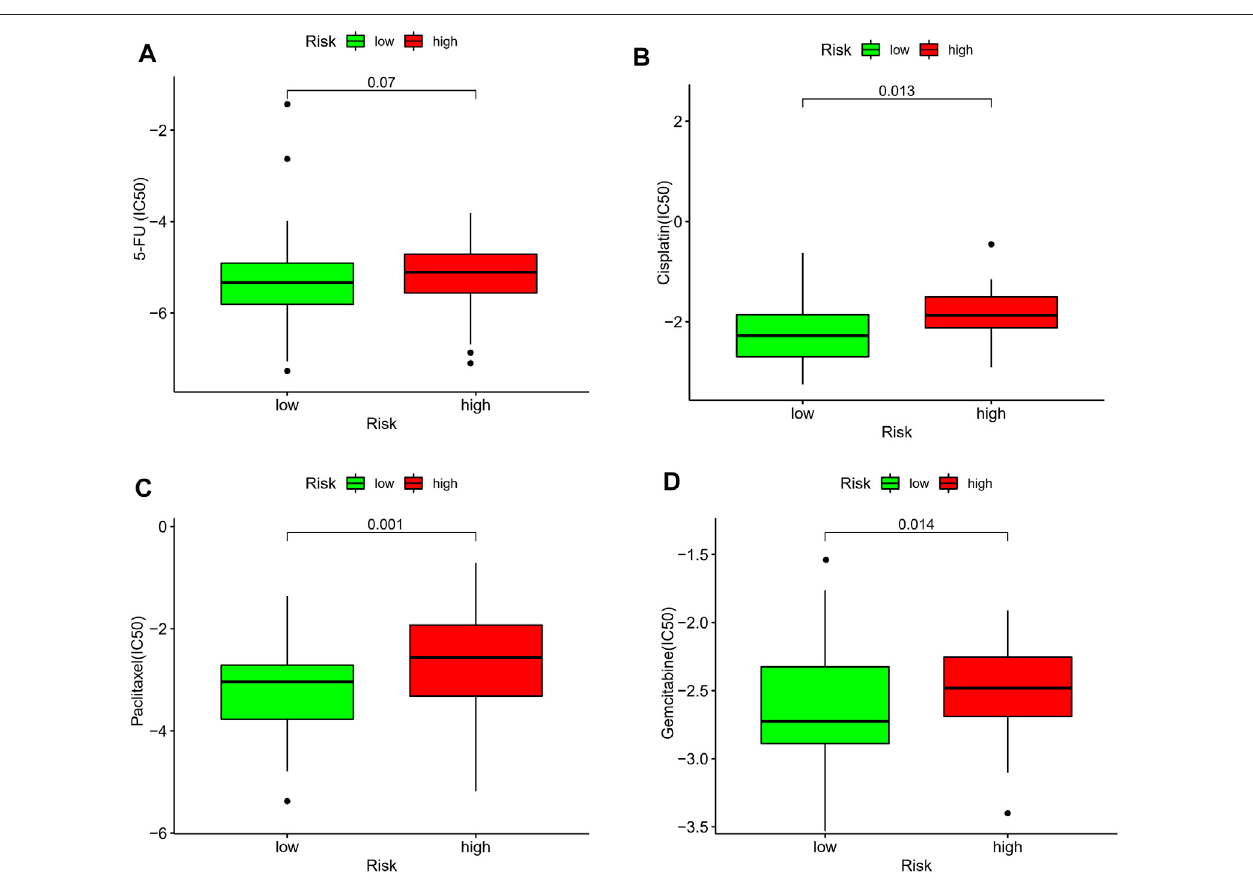
FIGURE10| Estimationoftheassociationsbetweenchemosensitivityandtheprognosticmodel.TheICI50of (A) 5- fl uorouracil, (B) cisplatin, (C) paclitaxel,and (D) gemcitabine, in the high-risk and low-risk groups.